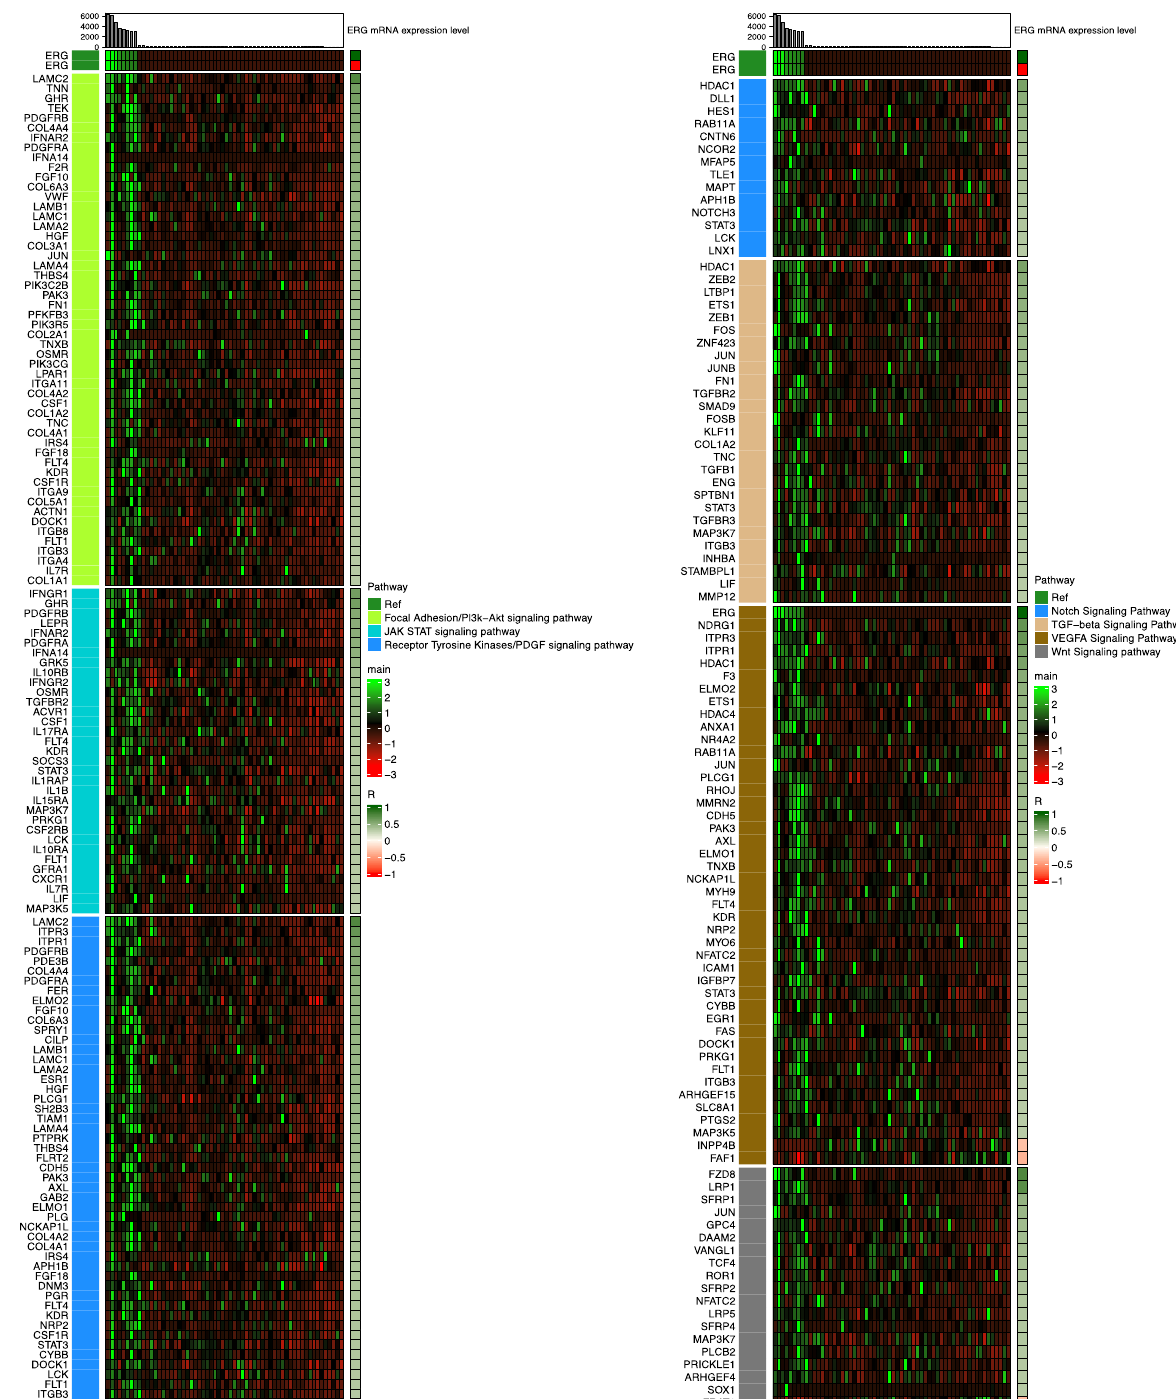
Figure 2. Heatmap for pathways and genes selected by ORA via CPDB in S:E fusion. Pathways and genes selected by ORA via CPDB in S:E fusion are presented by expression heatmap. The annotation on top represents ERG mRNA expression levels of S:E fusion-positive patients ( n = 10) and ERG fusion-negative patients ( n = 50). Rows are gene lists for the selected pathways calculated by a Pearson correlation test. Analysis parameters are described in the Experimental